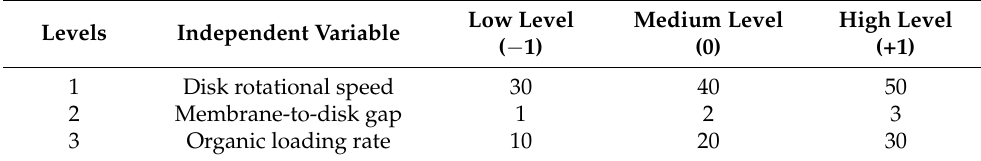
Table 2. Independent variables and levels used in central composite design.